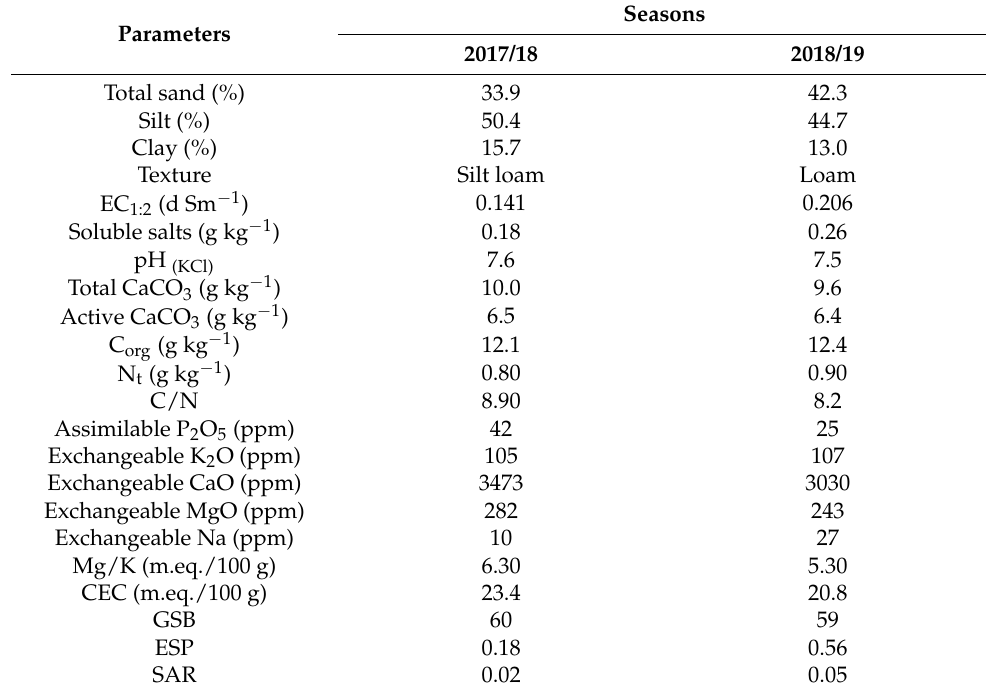
Table 1. Physical and chemical analysis of the experimental soil.